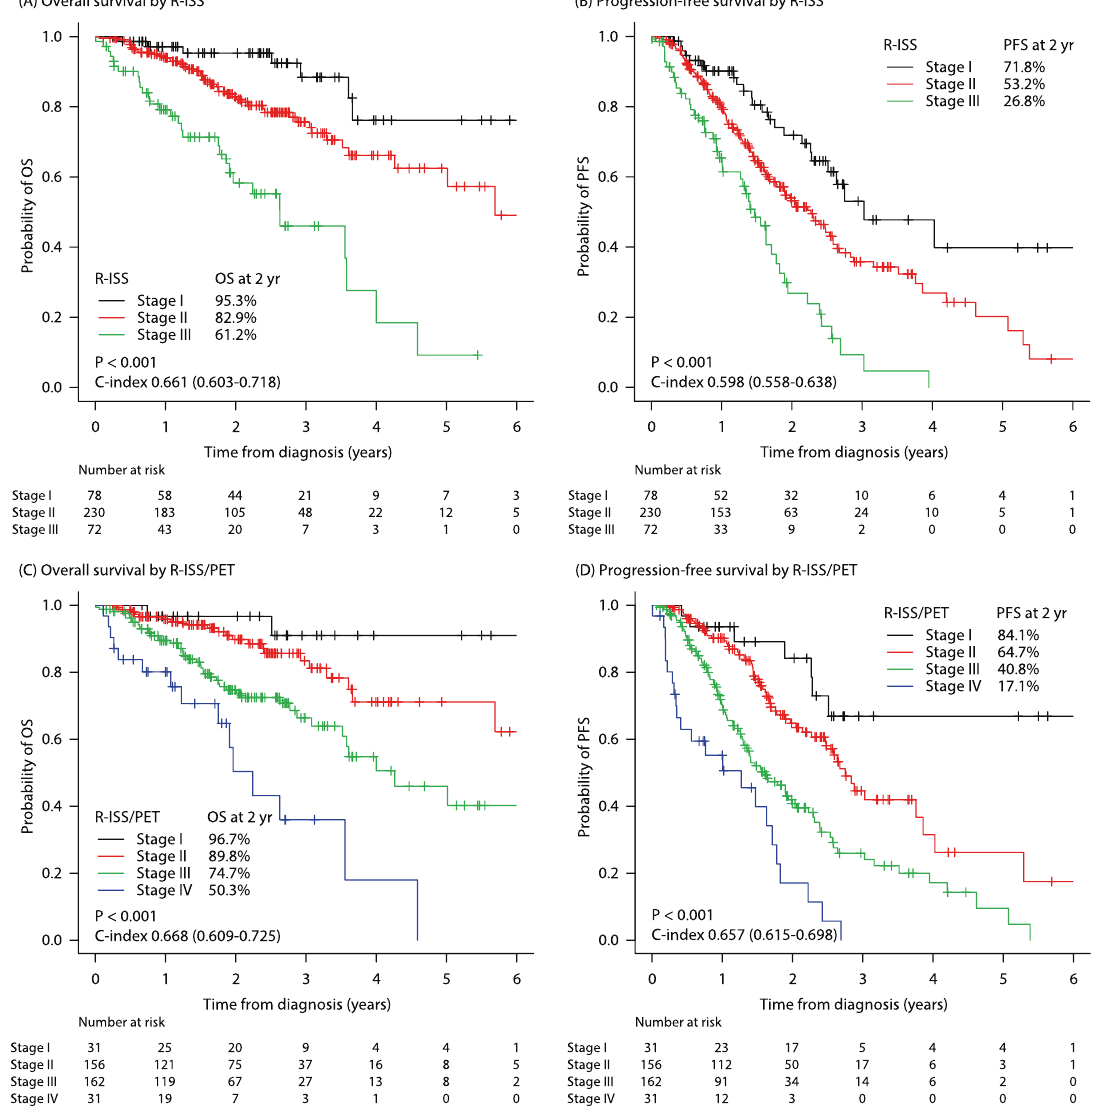
Fig. 2 Comparison of the R-ISS and the R-ISS/PET survival curves. A , B Overall survival (OS) rates and progression-free survival (PFS) rates by the R-ISS. C , D OS and PFS rates by the R-ISS/PET. Abbreviation: R-ISS Revised International Staging System, R-ISS/PET Revised International Staging System/positron emission